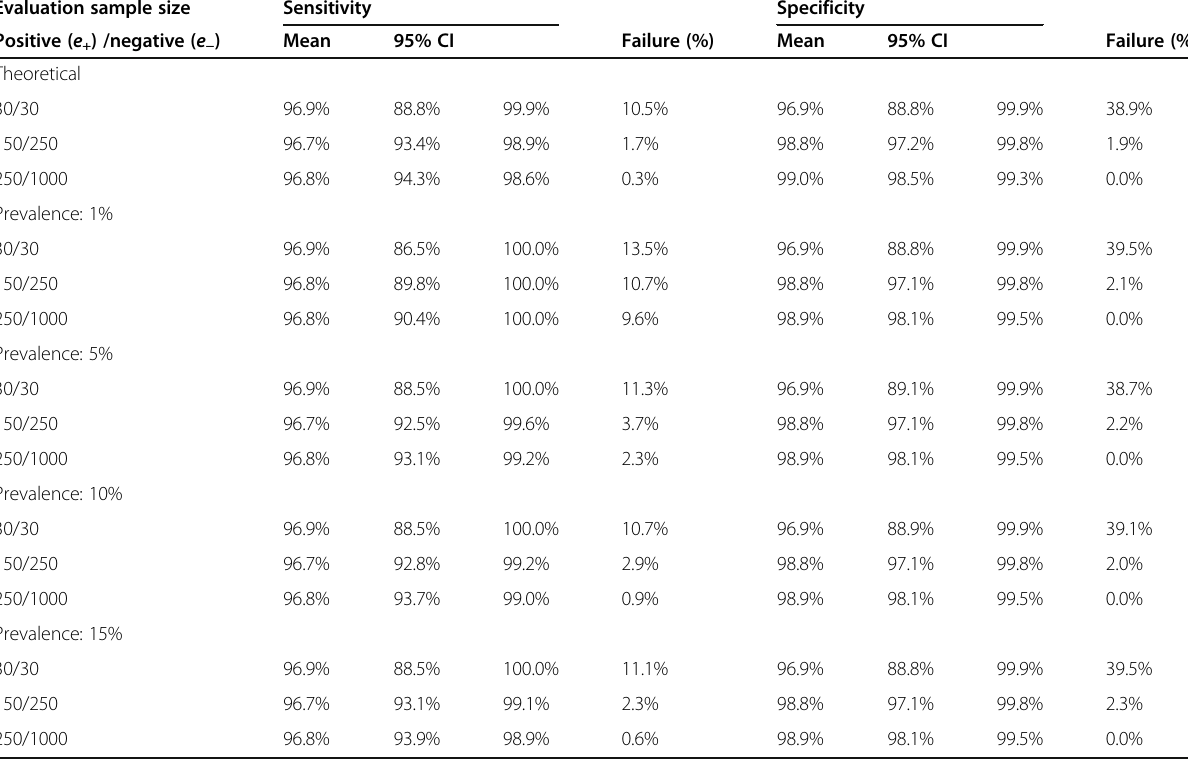
Table 3 D min scenario estimated mean and 95% confidence intervals of the sensitivity and specificity of a diagnostic test, given the test achieved 97% sensitivity and 99% specificity in the evaluation sample ( D min ), for a simulated population size of 5,000, where the evaluation sample sizes correspond to current guidelines Evaluation sample